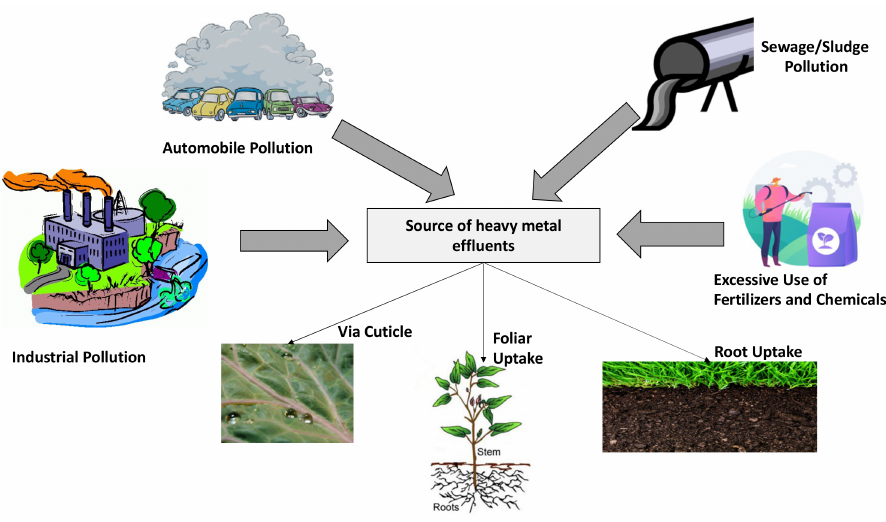
Figure 2. Ecosystem of heavy metal